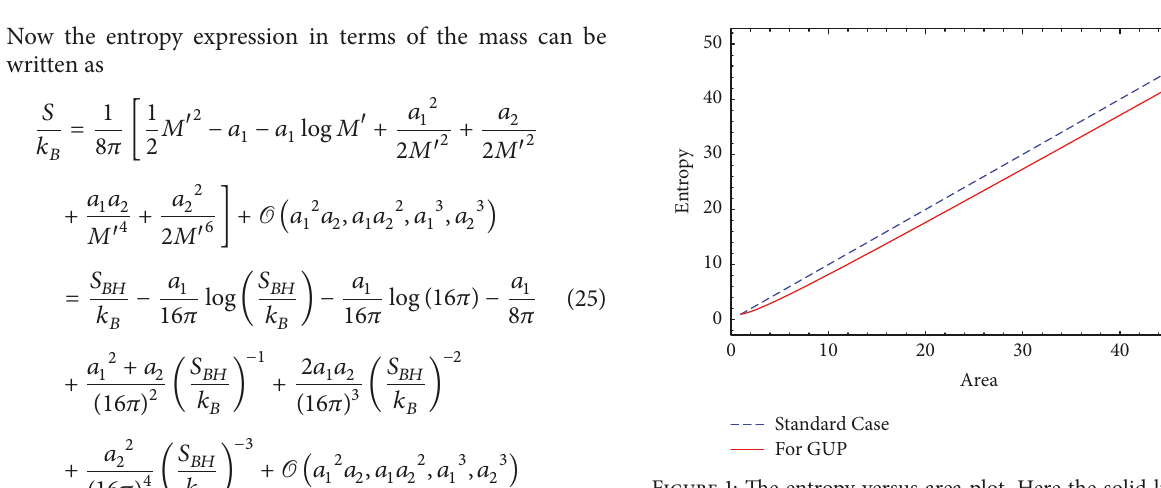
Figure 1: The entropy versus area plot. Here the solid line (lower curve) represents the GUP case (considering only the first two terms in the right hand side of (26)), and the dashed line (upper curve) represents the standard